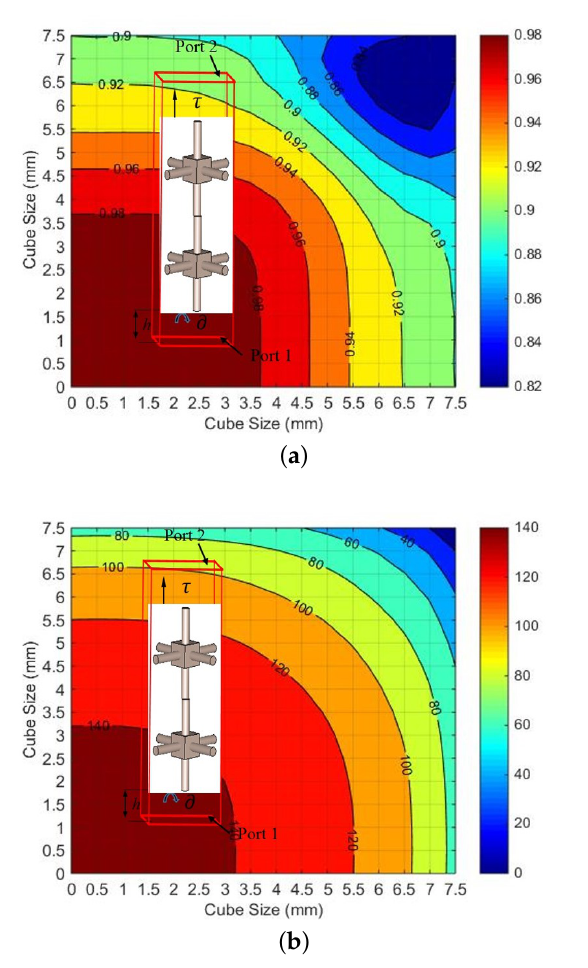
Figure 3. Estimate of ( a ) the transmission magnitude and ( b ) normalized transmission phase achiev- able using a dual-layer block expansion meta-structure